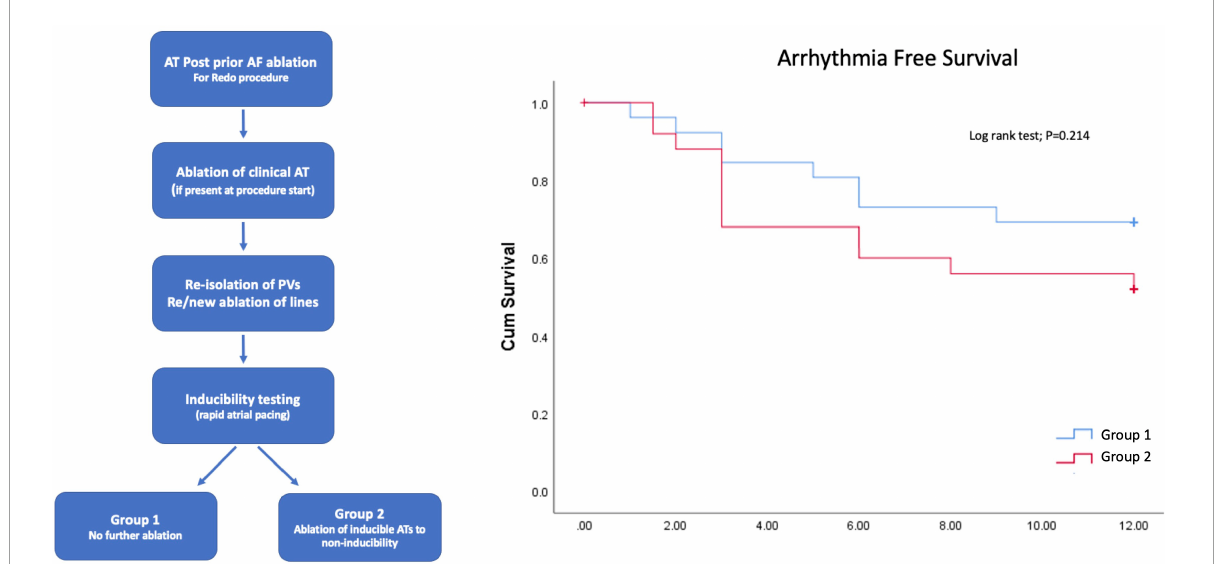
FIGURE1 Study design (left panel) and results (right panel) from the randomized Inducath study. No difference in arrhythmia-free survival was seen between those undergoing ablation of inducible atrial tachycardias (ATs) to non-inducibility compared to those undergoing ablation of the clinical AT